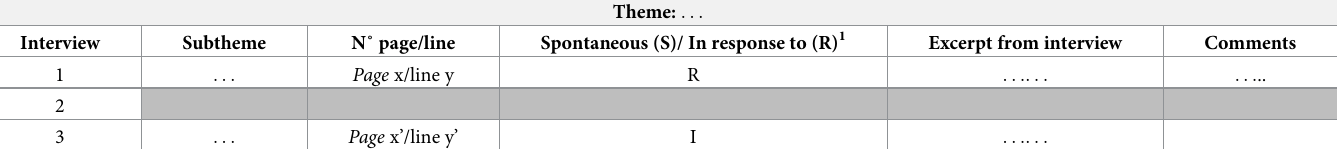
Table 2. Horizontal analysis (by